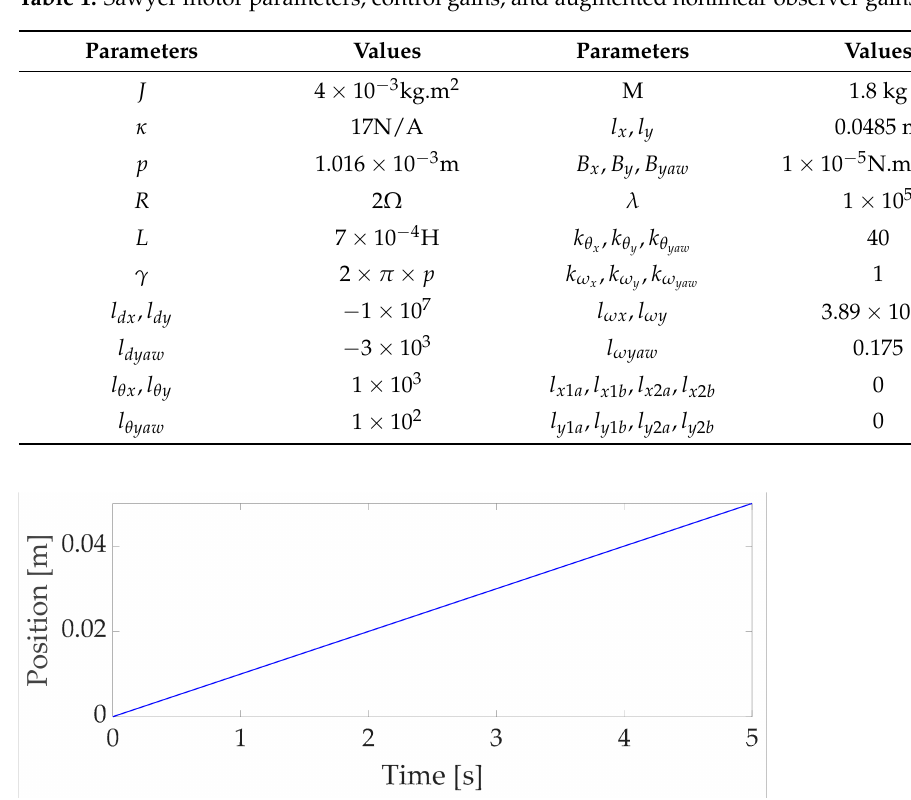
Table 1. Sawyer motor parameters, control gains, and augmented nonlinear observer gains.